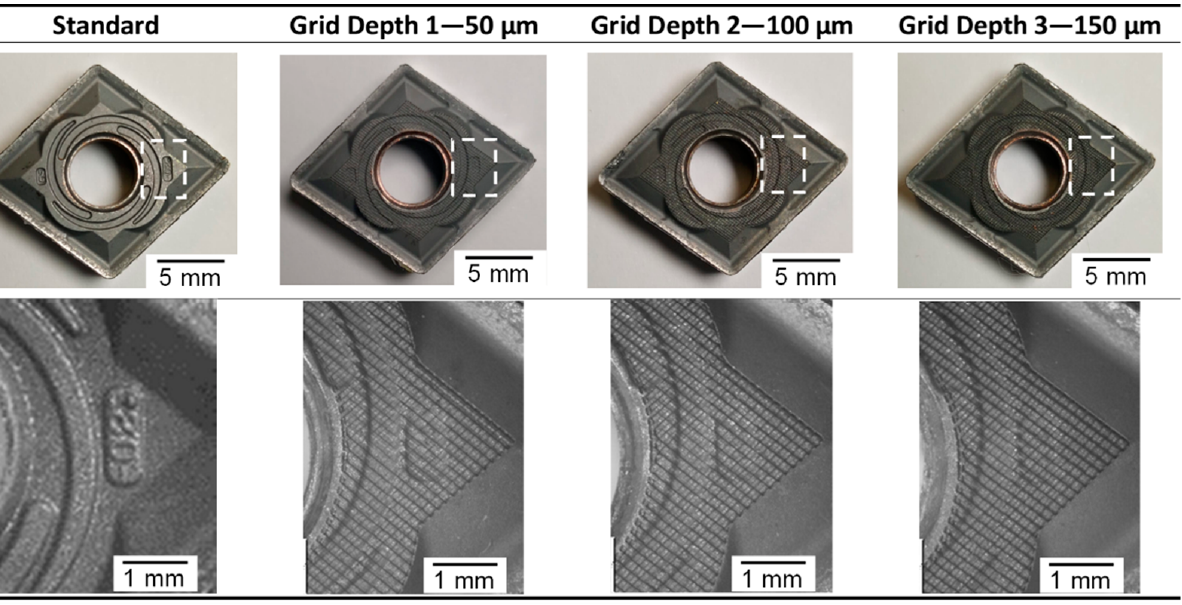
Figure 6. Cutting inserts images and the magnified view of their surface micro-textures.